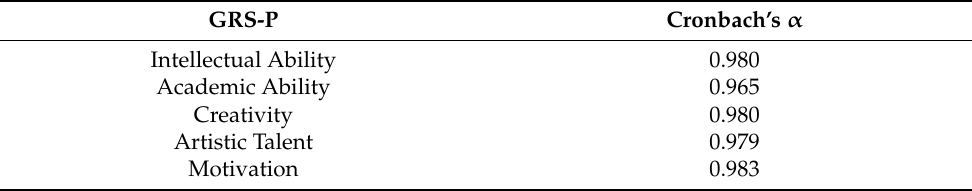
Table 2. Internal consistency reliability coefficients of the